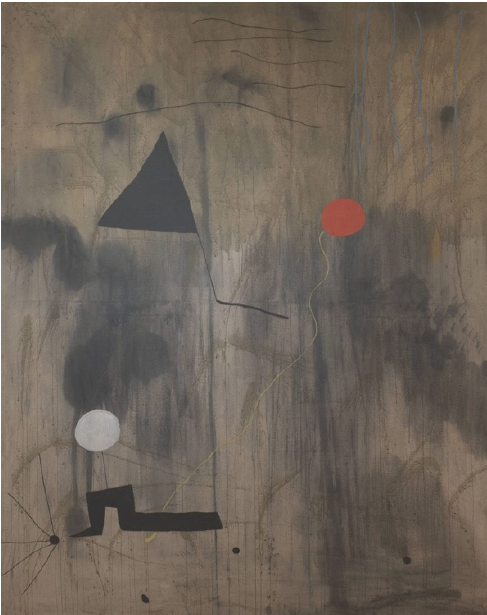
Figure 3. Joan Miró, The Birth of the World, 1925 . Image in the Public Domain .